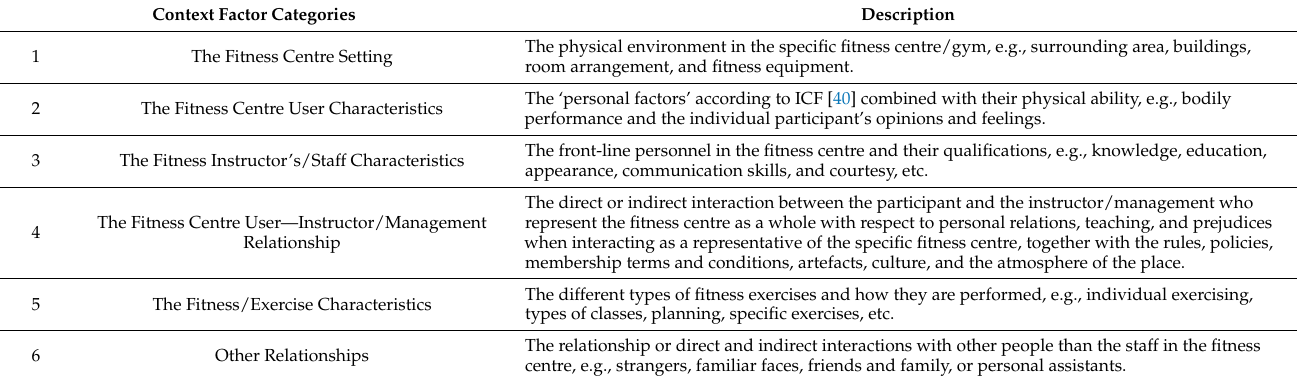
Table 1. A modified version of the Di Blasi framework of contextual factors. The six categories were used to categorise the barriers to, and facilitators of, exercising in fitness centres in this